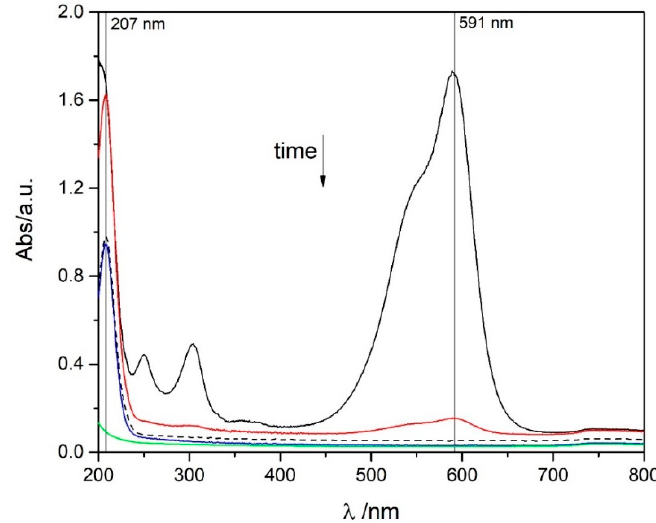
Figure 7. UV-Vis spectra of a mixture of Pb(II) and CV (10 mg dm − 3 ) before (black line) and after the treatment with K10-Mt at pH 2.0 for 20 min (red line), 60 min (blue line) and 12 h (green line). Dotted line is the UV-Vis spectrum of a solution 10 mg·dm − 3 of Pb(II).